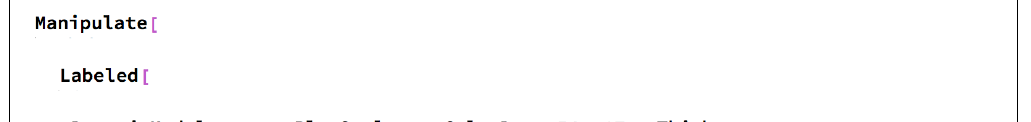
Figure 2. General code structure of the PES(Linear)-Tool.